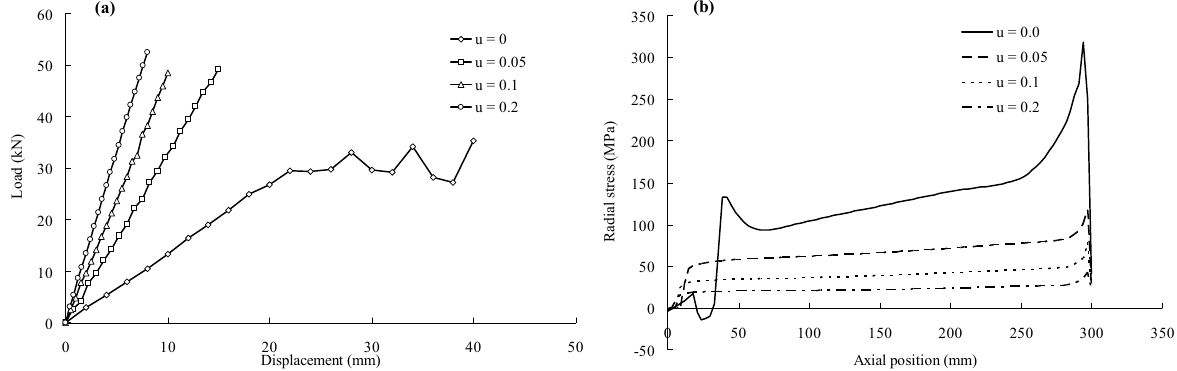
friction (COF); ( b ) the radial stress distribution of the inner cone anchor with a varying COF.